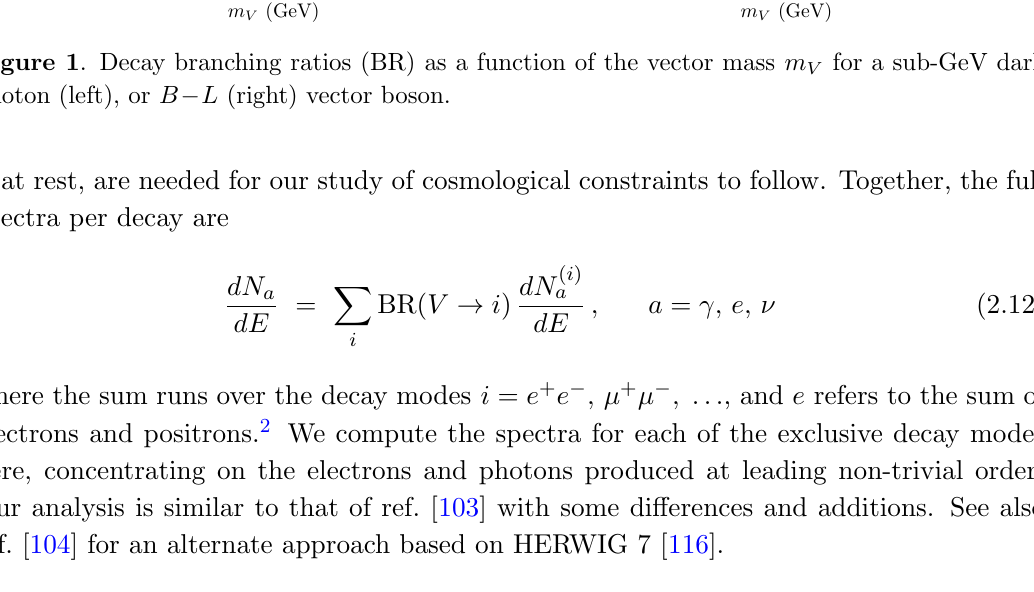
V for a sub-GeV dark